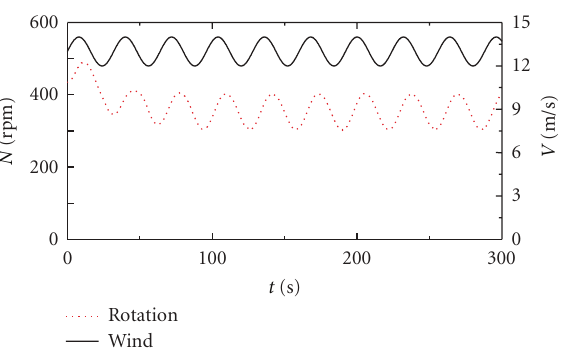
Figure 20: Time profile of rotational speed of pulsating wind in the case where V 0 = 13m/s, T = 32s, and I = 3kgm 2 .